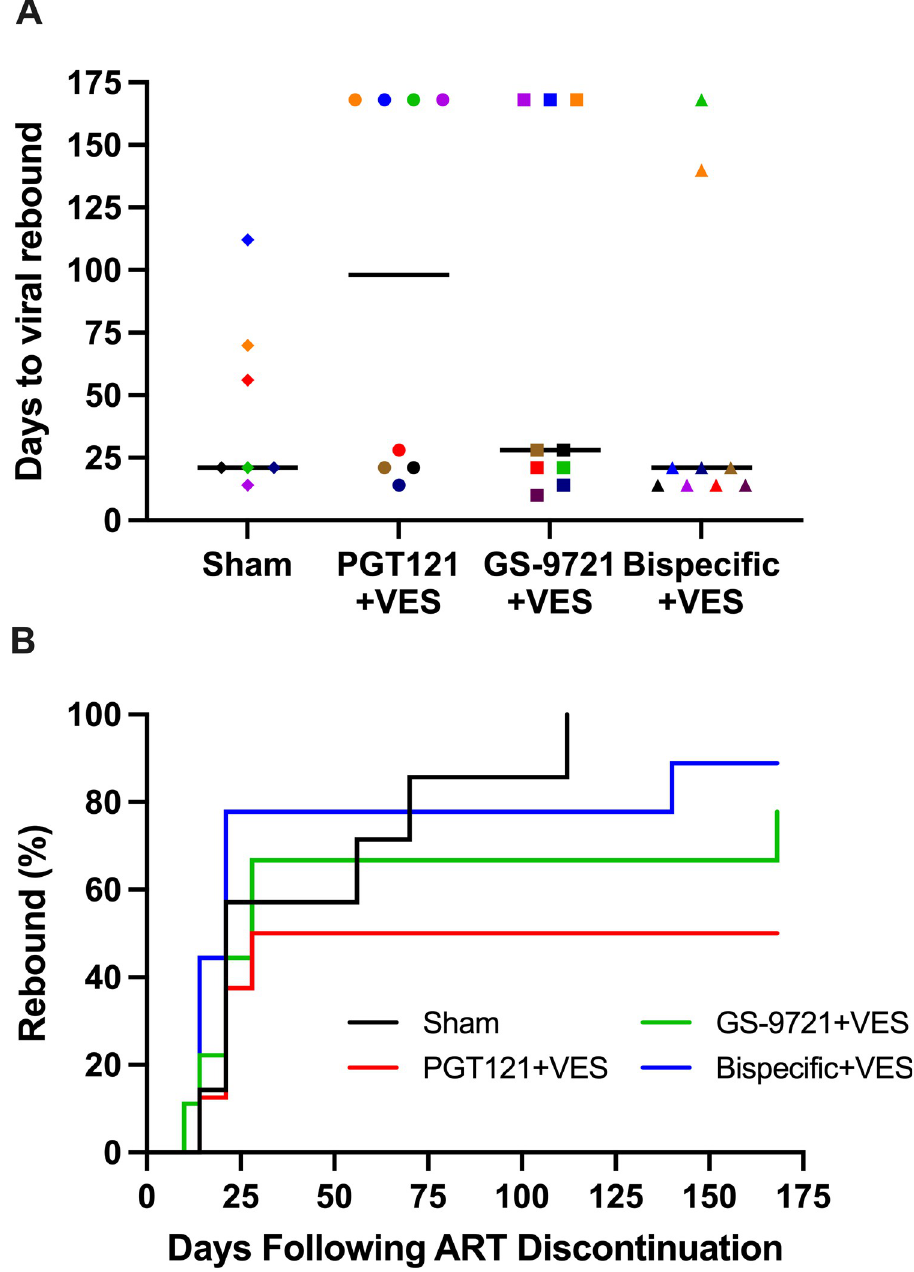
Fig 5. Analysis of viral loads following ART discontinuation. (A) Days to viral rebound per group. Black lines indicate median number of days for viral rebound load. Individual symbol and color coding as indicated in S1 Table. (B) Viral rebound analysis by Kaplan–Meier plot showing the percentage of rebounding animals per group as a function of time. effect of the antibody/VES treatment in those animals. The GS-9721+VES and bispecific+VES groups were comparable to the sham group with median time to viral rebound at 28 days and 21 days, respectively (Fig 5A and 5B). In the animals that rebounded, viral peak and set point were comparable across groups (S7 Fig) but in general were lower than observed with SIV.